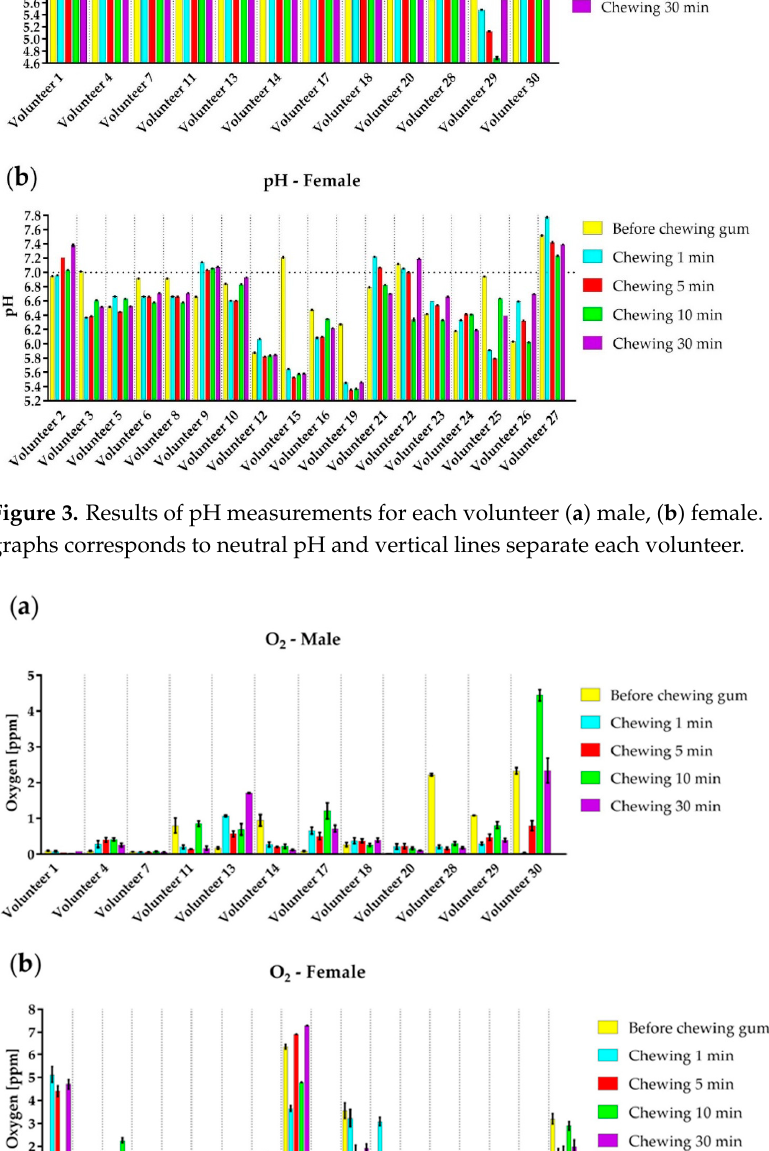
Figure 5. Results of CO 2 measurements for each volunteer ( a ) male; ( b ) female.